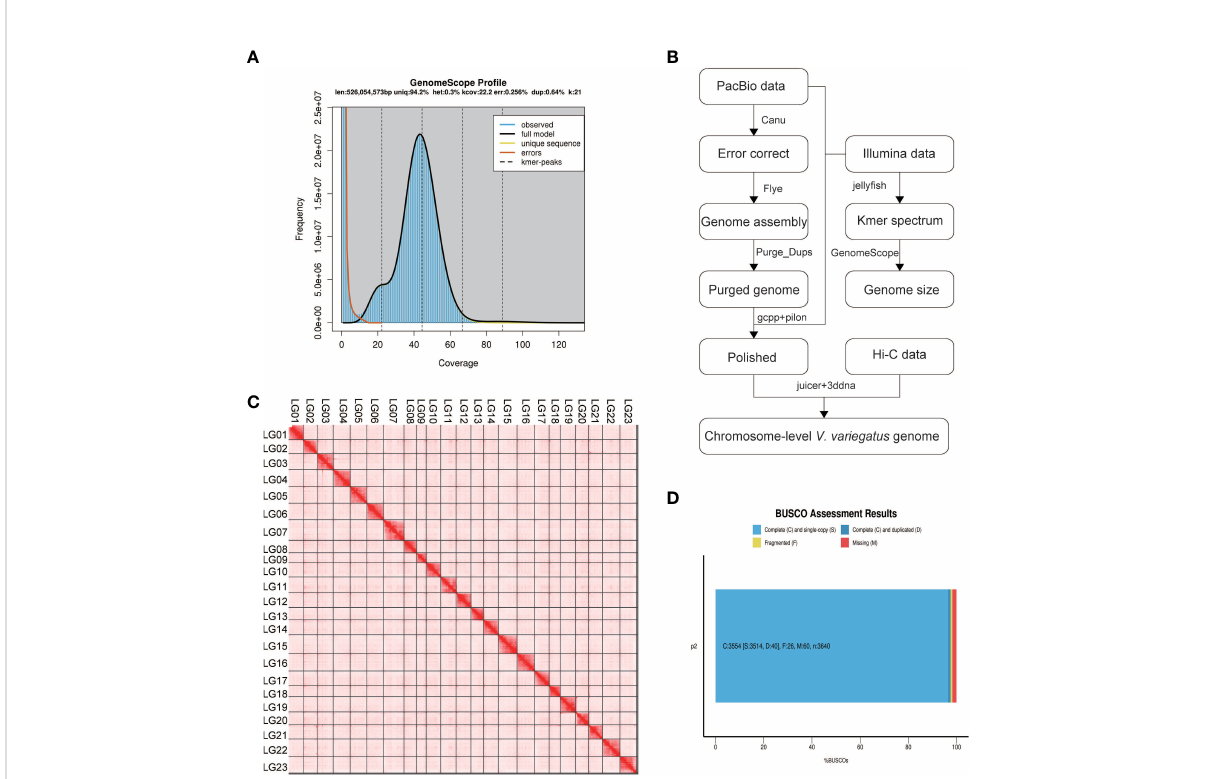
FIGURE 1 Genome assembly information. (A) Schematic illustration of the Verasper variegatus genome assembly pipeline (B) 21-mer estimates of genome size. The x-axis is the depth (X) and the y-axis is the representative the kmer frequency. The estimated size of the genome is 526.05Mb, and the heterozygosity is 0.3%; (C) Verasper variegatus genome contig contact Heatmap using Hi ‐ C data. LG 01-23 representing the 23 pseudo- chromosomes. The color bar illuminates the contact density from red (high) to white (low); (D) BUSCO evaluation results, 3554 (97.6%)